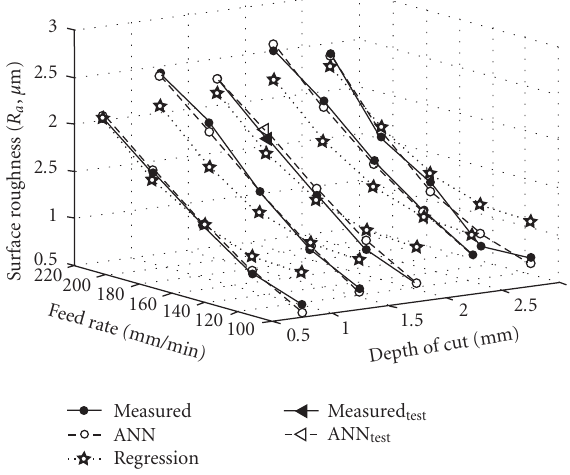
Figure 17: Comparison of actual, regression, and ANN approach values for insert radius of